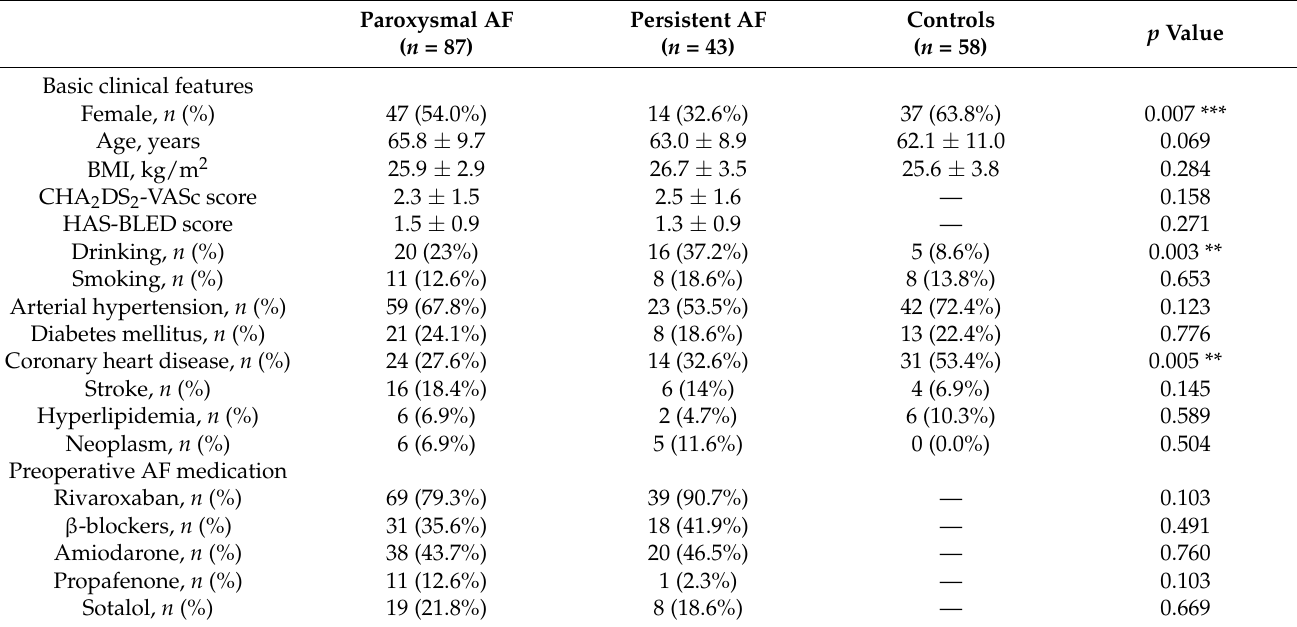
Table 1. Baseline clinical characteristics of study